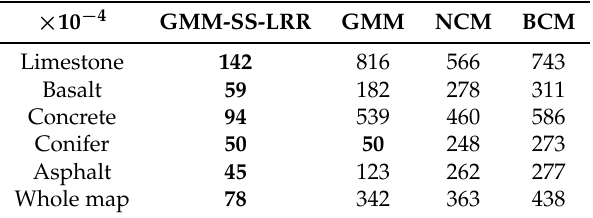
Figure 5. Histograms of pure pixels for the five materials (when projected to one-dimensional space determined by performing PCA on the pure pixels of each material) of the synthetic dataset. The probability of each distribution was calculated by multiplying the value of the density function at each bin location with the bin size. Table 1. Abundance errors for synthetic dataset.